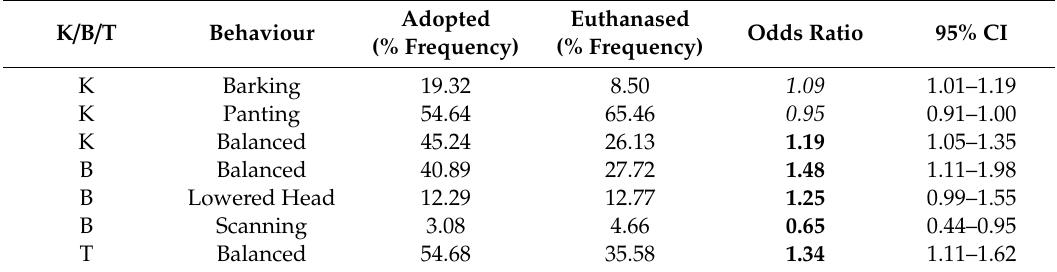
Table 12. Frequency of behaviours in the kennel, behaviours in the formal assessment and time alone test of dogs ( n = 38) that were adopted or euthanased, together with the significance of the di ff erence tested by binary logistic